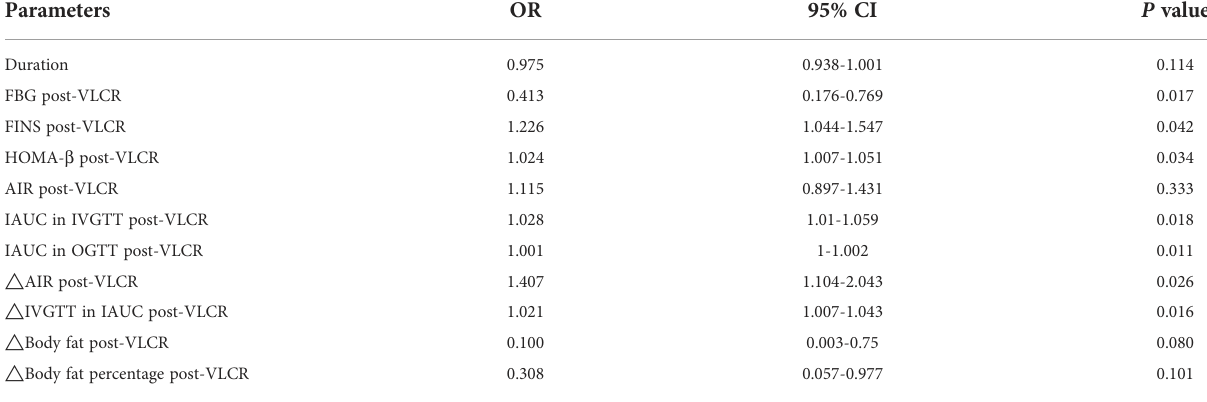
TABLE 9 Univariate logistic regression analysis for predictors of diabetes remission.